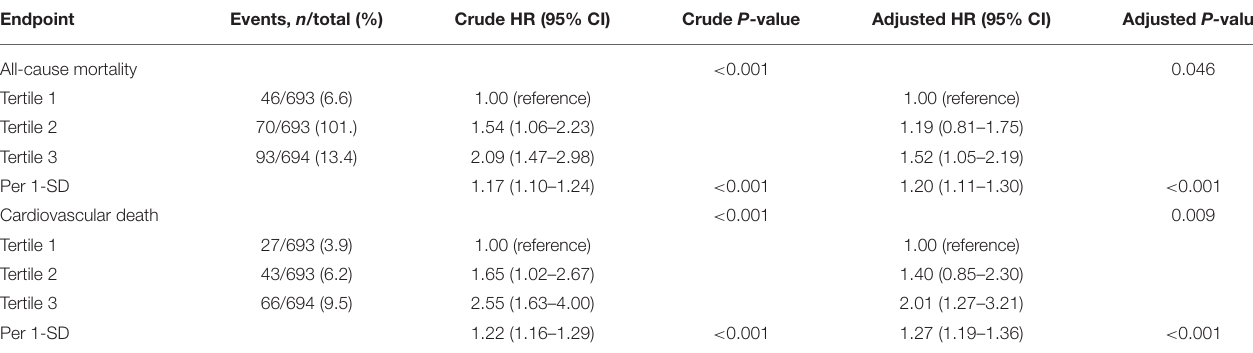
TABLE 2 | Cox regression models in the prediction of all-cause mortality and cardiovascular death according to the triglyceride to high density lipoprotein-C ratio at